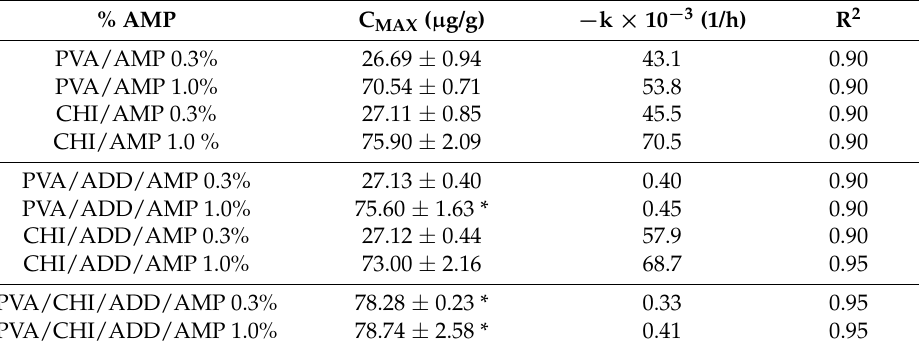
Table 3. Release studies of AMP from the prepared